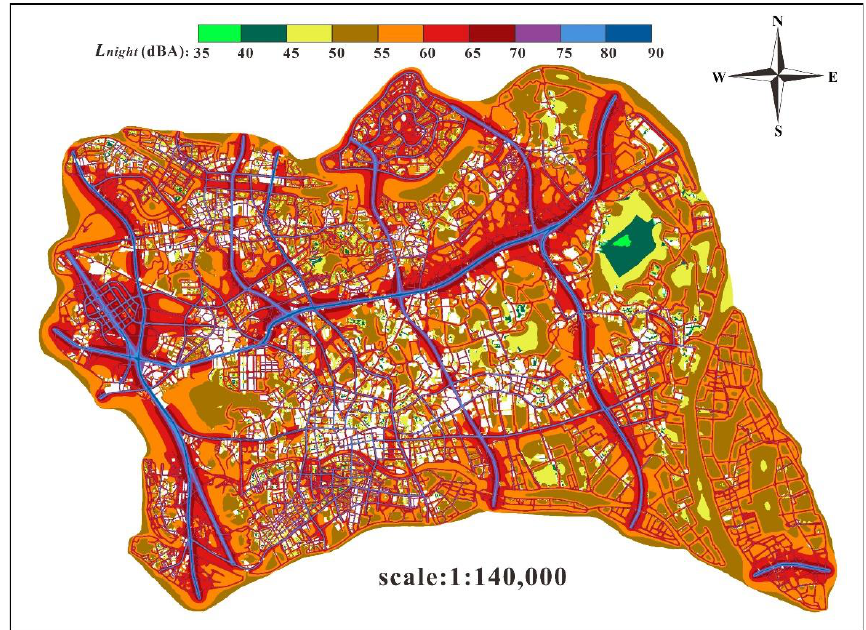
Figure A2. Nighttime urban traffic noise map of Panyu District, Guangzhou City [36].